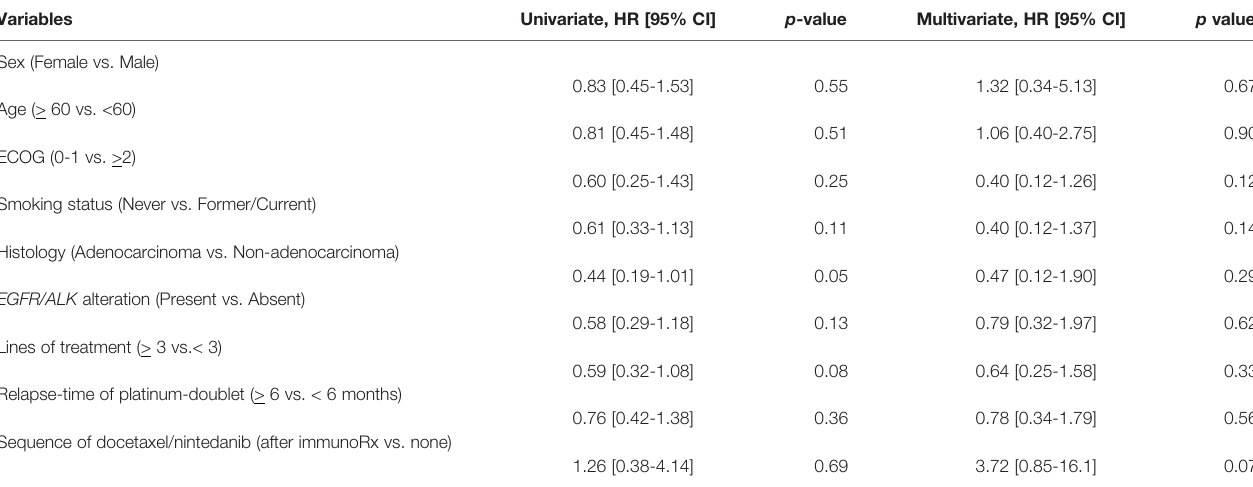
TABLE 3 | Univariate and multivariate analysis of prognostic factors to overall survival bene fi t including demographic characteristics, treatment by using Cox proportional hazards regression model. Variables